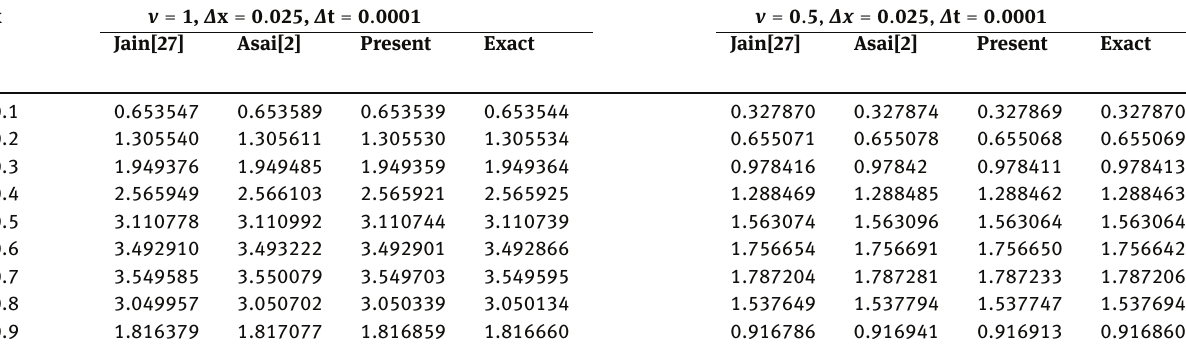
Table 9: Comparison between exact and existing numerical solutions of Example 3 for ν = 1 and ν = 0.5 at different spatial